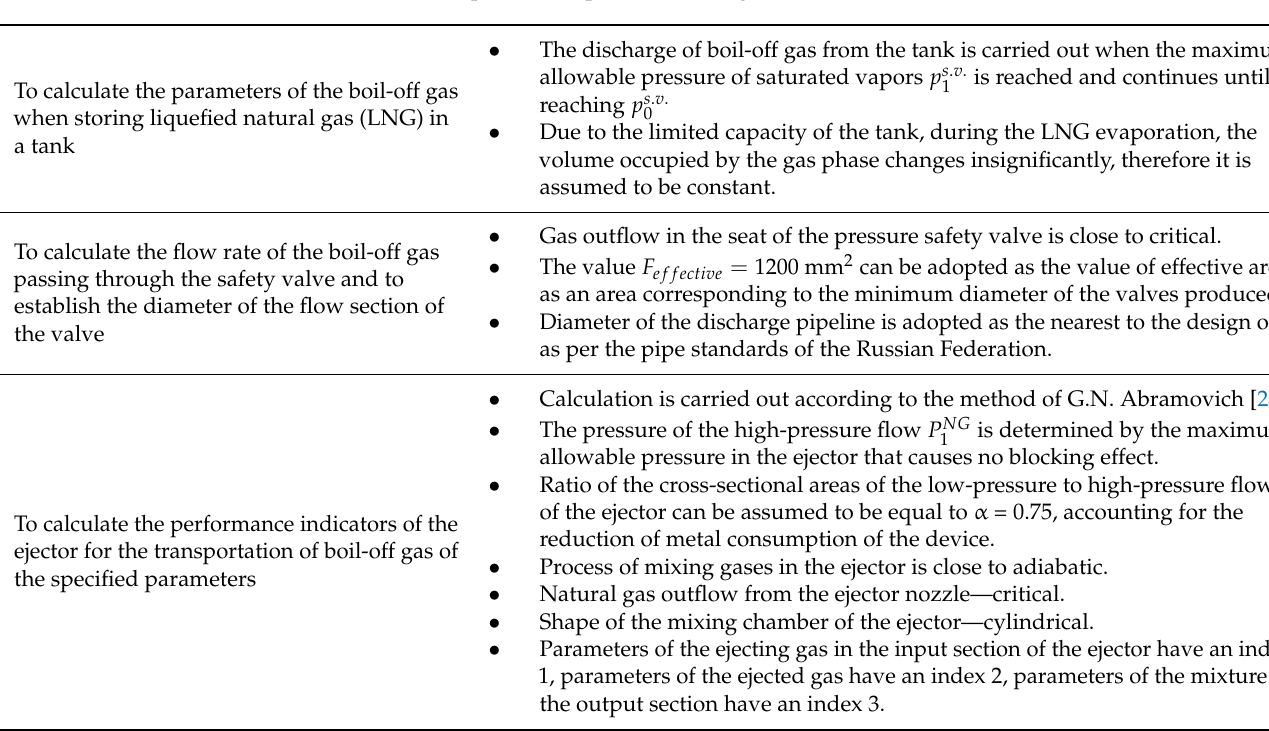
Table A1. Adopted assumptions and